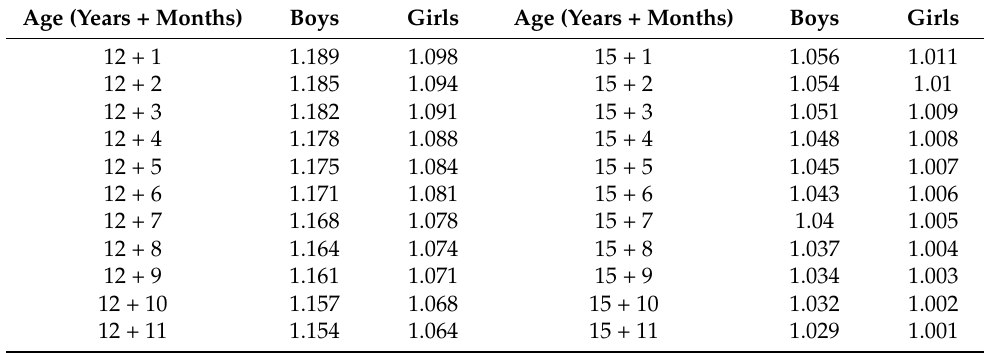
Table 3. Sitting height Multiplier for 12+ to 15 years of